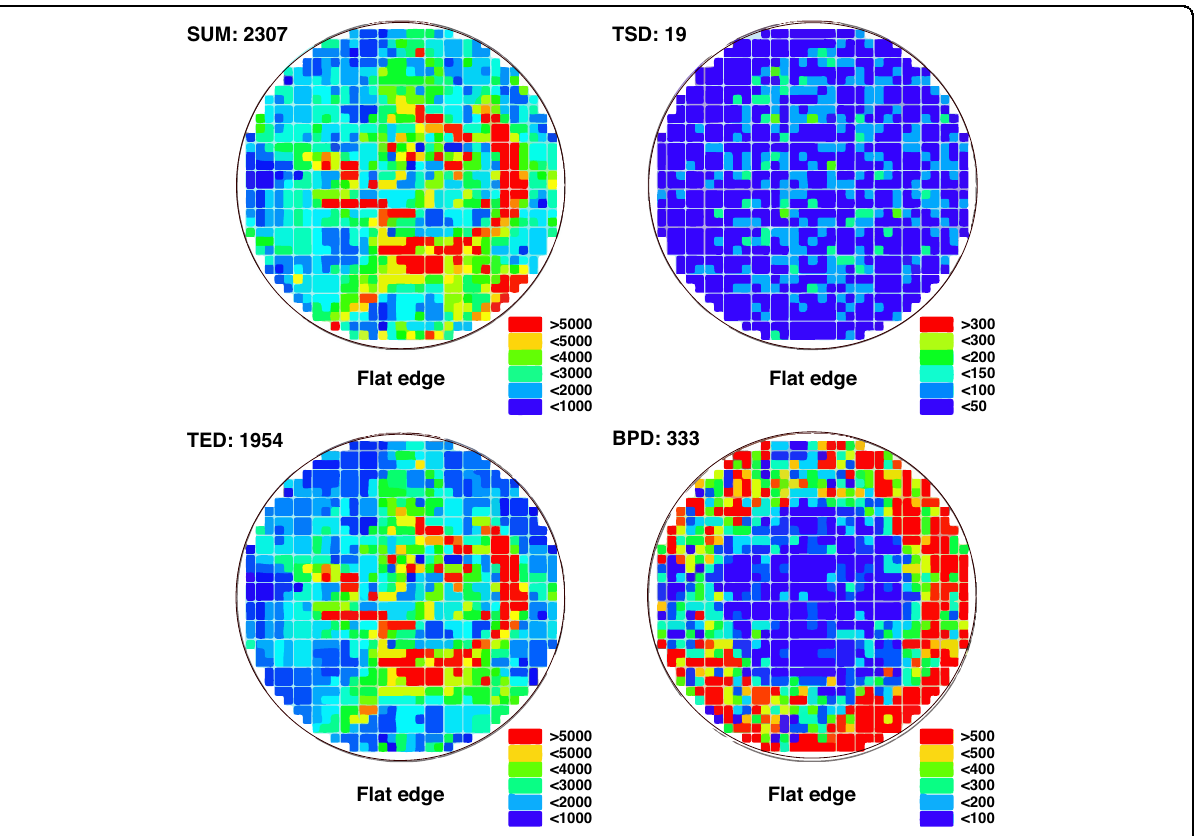
Fig. 6 The dislocation distribution of 6-inch n-type SiC substrate